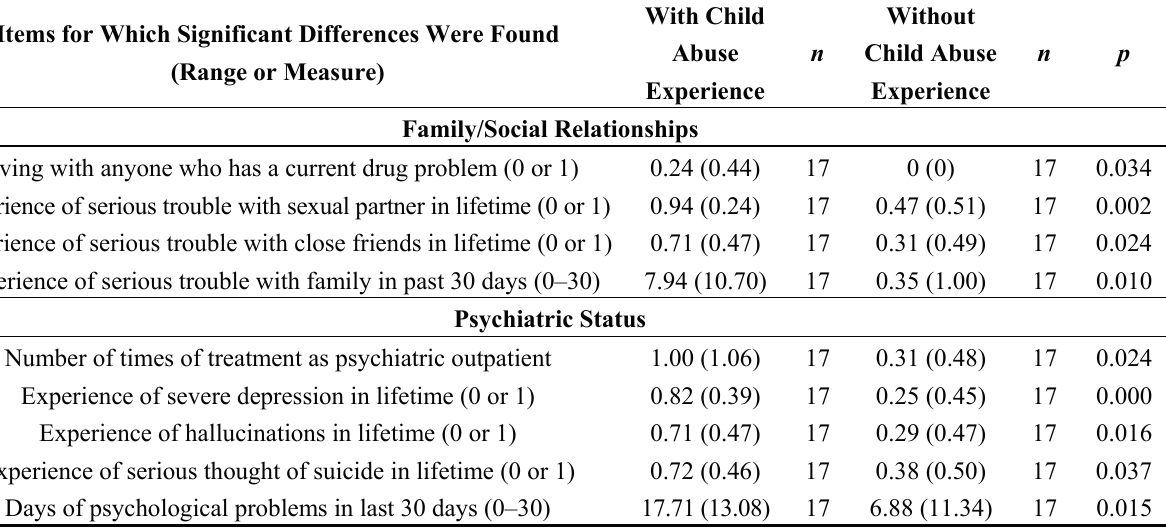
Table 4. Items on the ASI-J affected by child abuse experiences (females). Items for Which Significant Differences Were